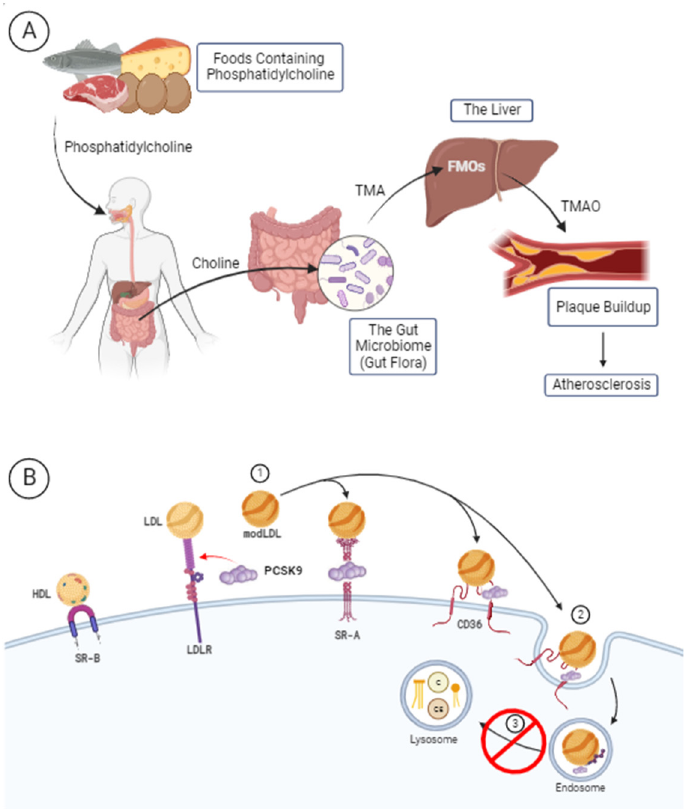
Figure 1. ( A ) Endogenous production of TMAO from dietary precursors. ( B ) Mechanism of action of PCSK9 in the disruption of LDL receptor recycling. Created with BioRender.com (accessed on 9 November 2022).